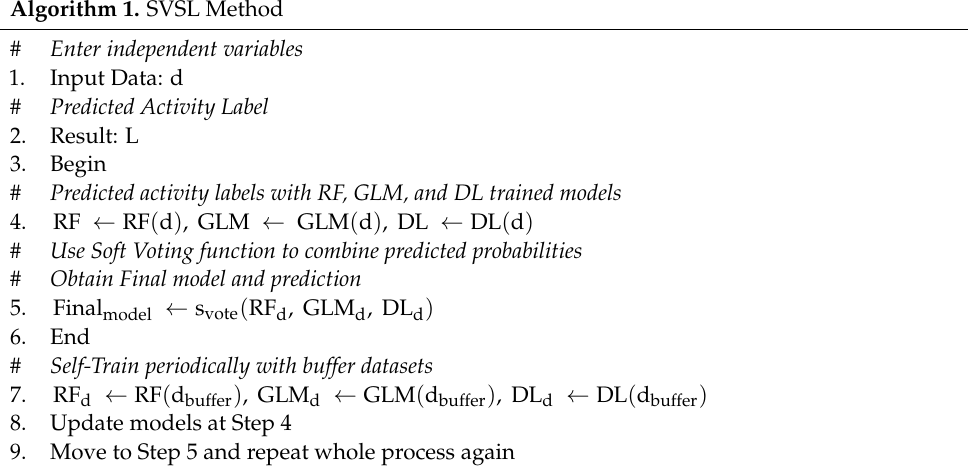
Figure 3. Prediction accuracy (%) of different DL models.